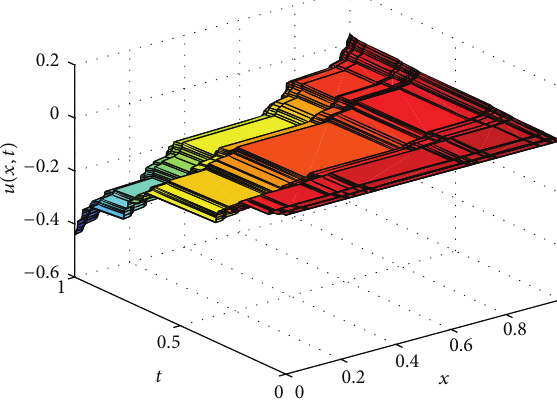
Figure 3: The plot of solution of (35) when 𝛼 = ln 2/ ln 3